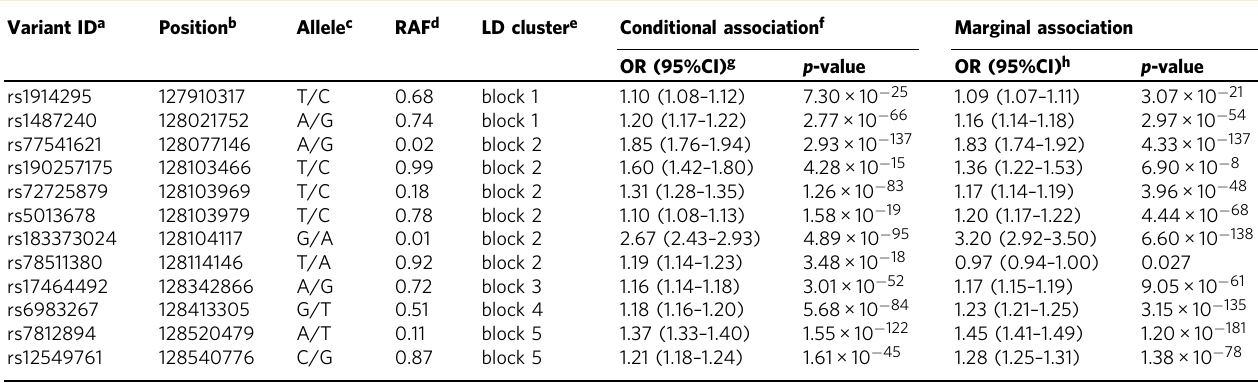
Table 1 Marginal and conditional estimates for genetic markers at 8q24 independently associated with prostate cancer risk Variant ID a